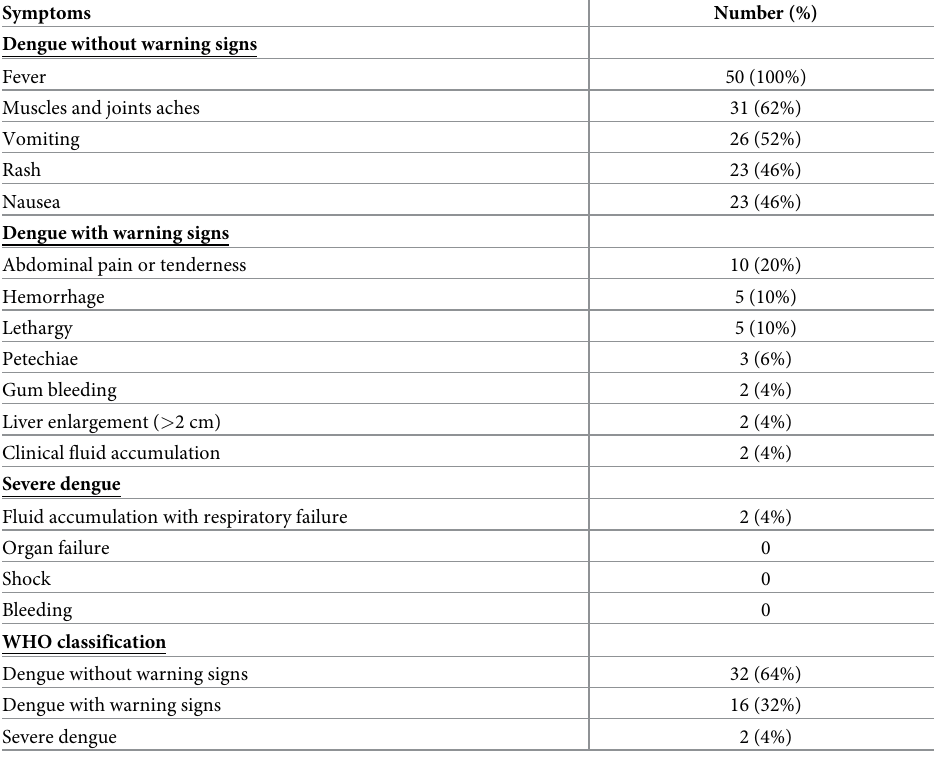
detection of DENV 1–4 serotypes. For conventional PCR, cDNA was prepared using Proto- Script 1 First Strand cDNA Synthesis Kit (Cat. No. E6300S) according to the manufacturer’s instructions.